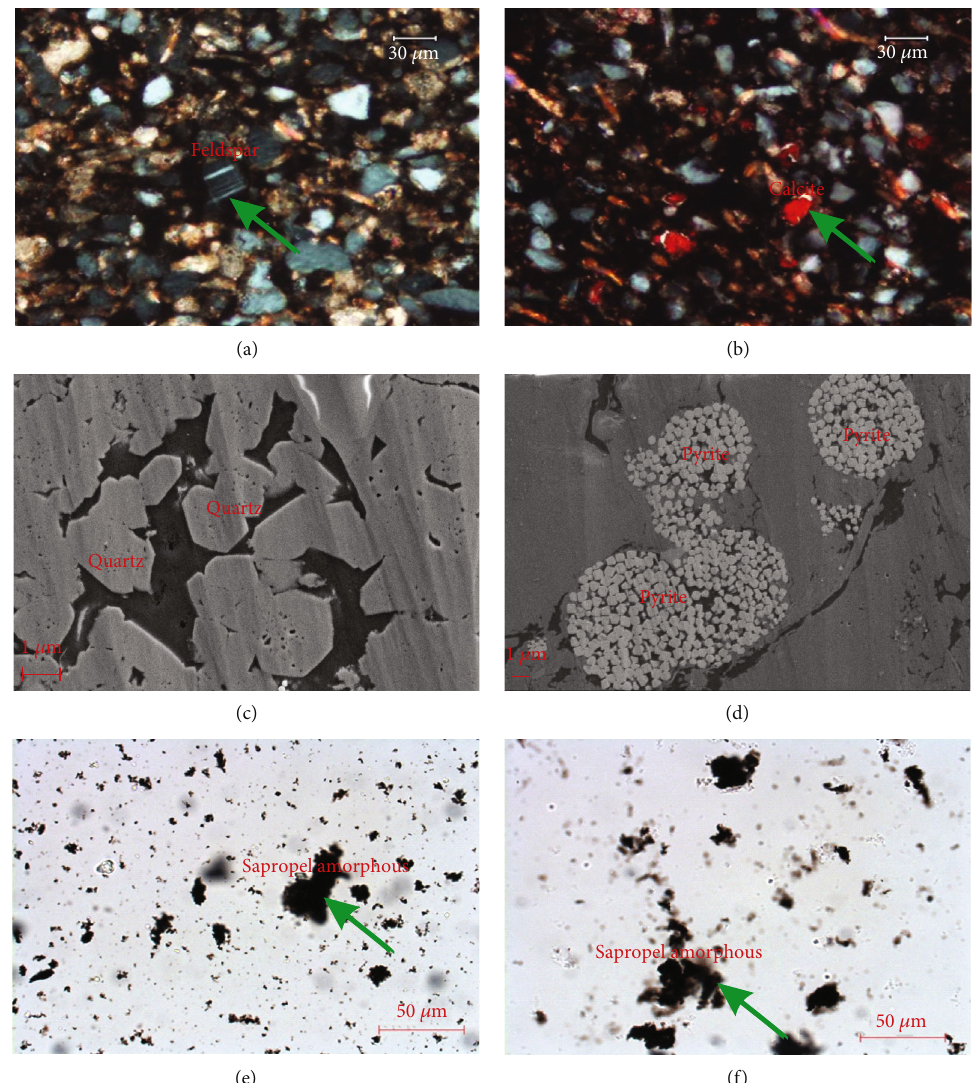
Figure 2: Mineralogical characteristics of black shale in Wufeng-Longmaxi Formation. (a) Well QD1, 1098.92m, feldspar; (b) well QD1, 1101.38m, calcite; (c) well ZY1, 2620.01m, quartz; (d) well ZY1, 2622.07 m, moldy spherical pyrite; (e) well ZY1, 2618.01m, sapropel amorphous; (f) well ZY1, 2616.81 m, sapropel